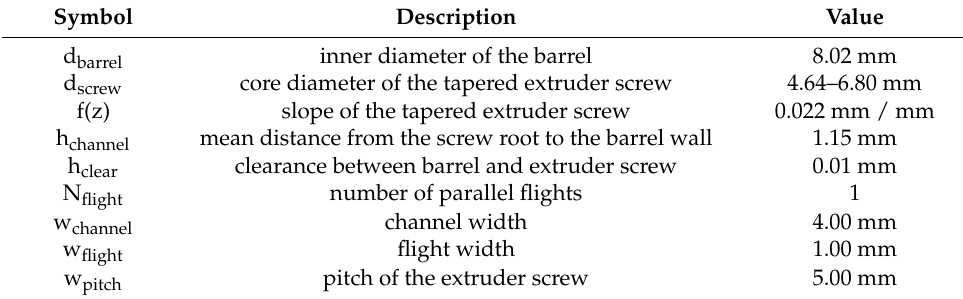
Figure 1. Drawing of the hot-end ( a ): (A) screw, (B) first barrel part, (C) second barrel part, (D) nozzle mounting and (E) printer nozzle. Sketch of the screw geometry ( b ). Table 1. Dimensions of the extruder screw.